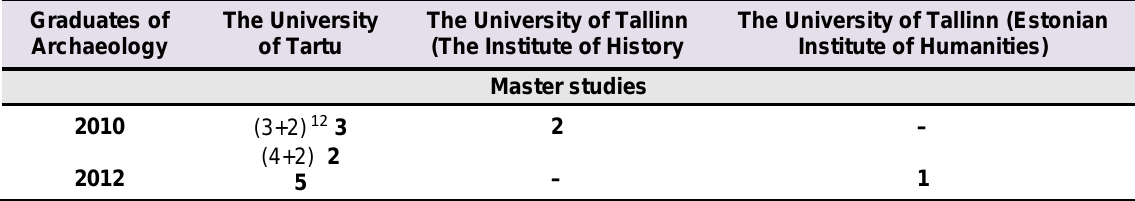
Table 12 - The graduates of Master studies in 2010 and